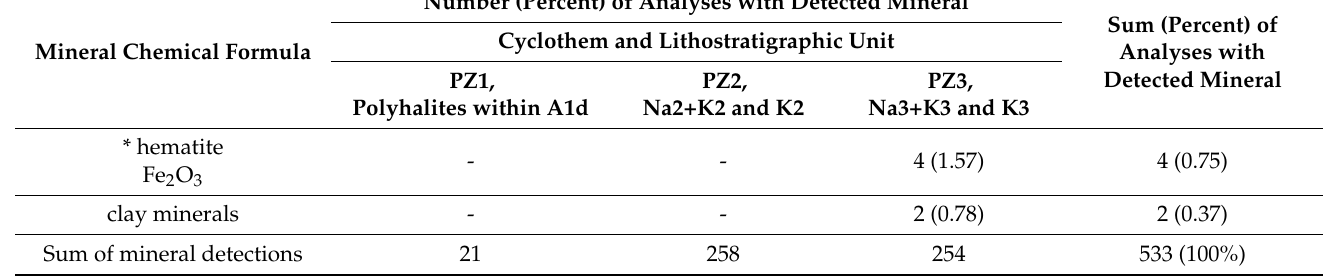
(Figure 12F), kieserite (Figure 12C,D), and anhydrite (Figure 12E). The frequent (6–8%) ones are: kainite, polyhalite (Figure 12E), and quartz. The rare (1–3%) minerals that were detected: bischofite (Figure 12F), bloedite, carnallite (Figure 12A), cronstedtite, gypsum, magnesite, talc, pyrite, boracite, and minerals of chlorite group (Table 4). Calcite, leonite, loewite, langbeinite, nantokite, picromerite, spodumene, starkeyite, hydrotalcite,